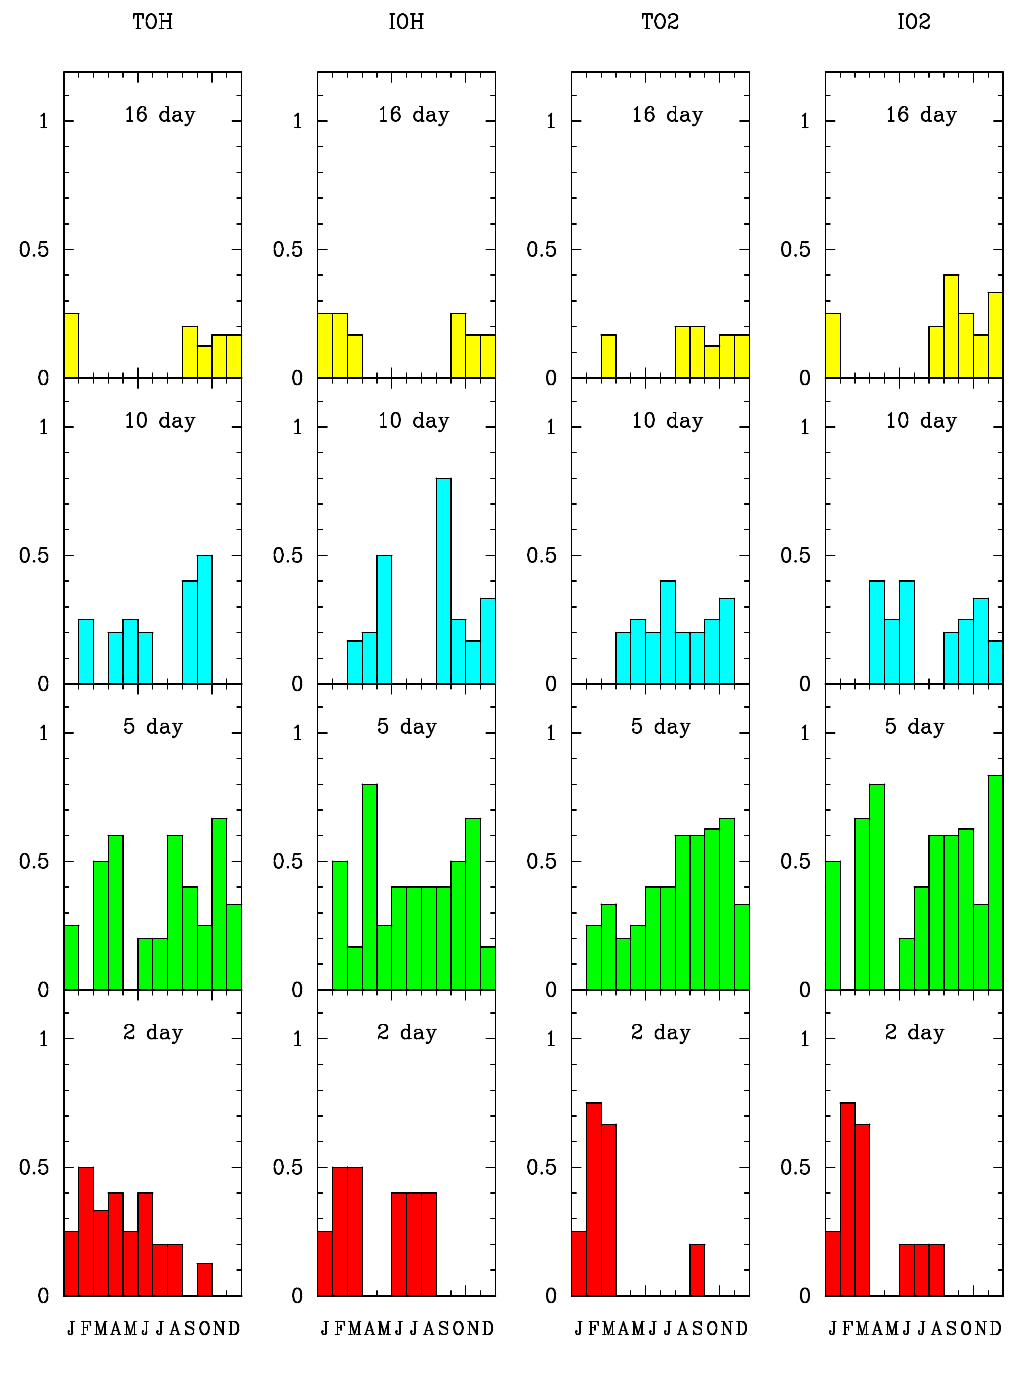
Fig. 5. Seasonal dependence of the probability of wave